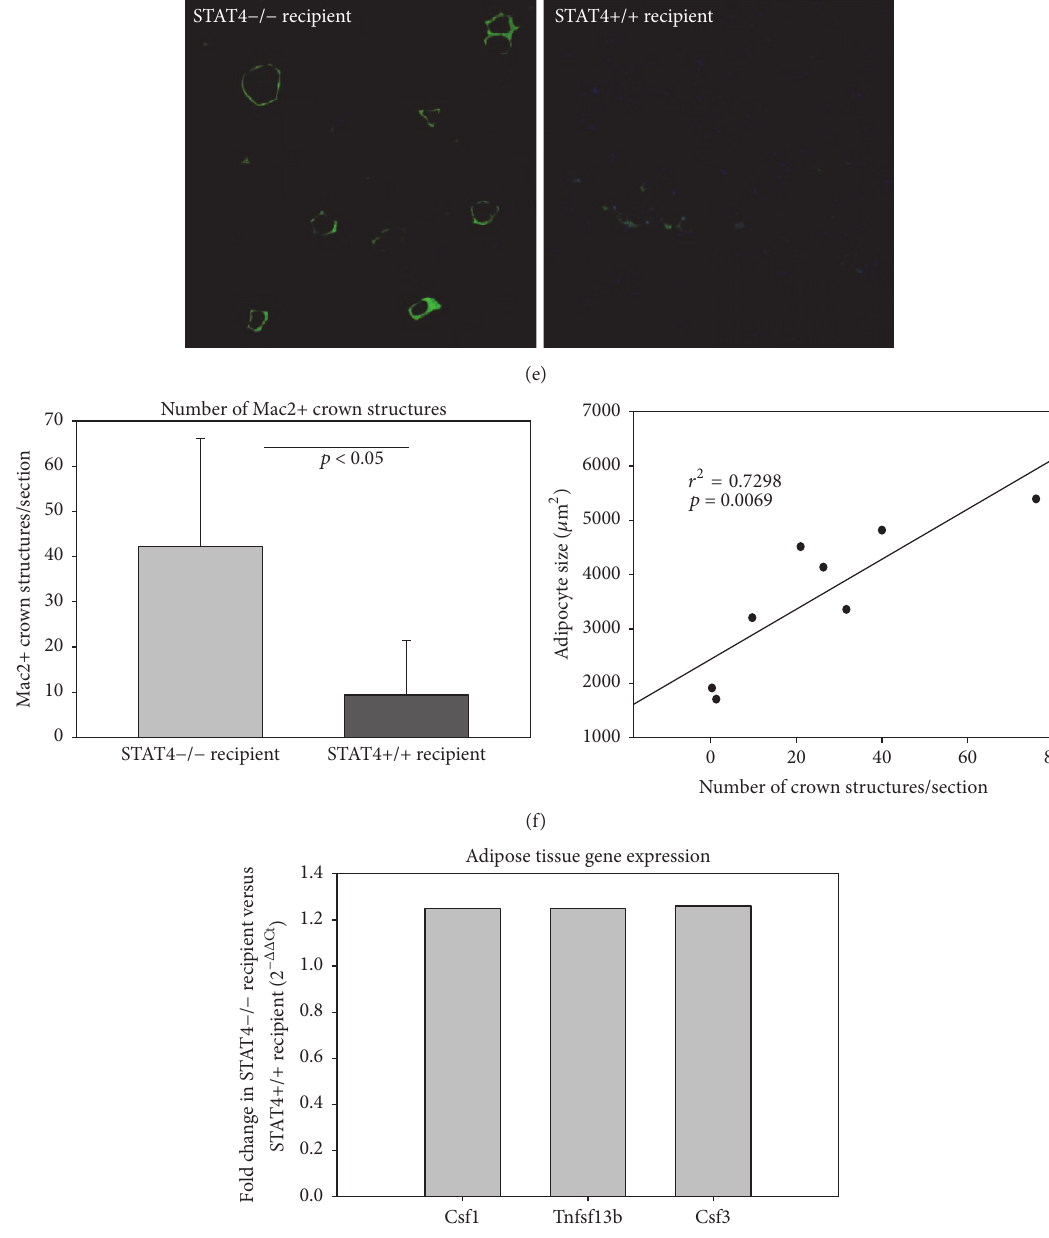
Figure 2: Adipose tissue morphometry and inflammation in STAT4 chimeras after 15 weeks on HFD. Adipocyte size distribution (a) and adipose tissue morphometry (b) were performed in 4 mice/group. Adipose tissue of STAT4 − / − recipients displayed higher percentage of large adipocytes, increased average adipocyte size, and lower cellularity. Representative micrographs of epididymal adipose tissue sections are shown in (c). DNA was extracted from adipose tissue and amplified with specific primers to determine STAT4 positivity. Note that STAT4 is present in adipose tissue of both chimeras indicating significant infiltration of STAT4+/+ hematopoietic cells in the STAT4 − / − recipients; histogram represents percentage of the donor cell genotype signal out of the total signal determined by densitometry of respective bands in agarose gels (d). Representative immunofluorescence pictures of the Mac-2 positive crown-like structures (e); morphometric analysis (f) was performed in 𝑛 = 4 mice/group. The number of crown-like structures is significantly correlated with adipocyte size ( 𝑛 = 8 mice). Gene array containing a panel of 72 genes involved in inflammation was performed in STAT4 − / − and STAT4+/+ recipients ( 𝑛 = 3 /group) (g). Histogram shows the three significantly increased genes in STAT4 − / − recipients. Data represents average ± SD and the null hypothesis was rejected for 𝑝 < 0.05 . ∗ 𝑝 < 0.05